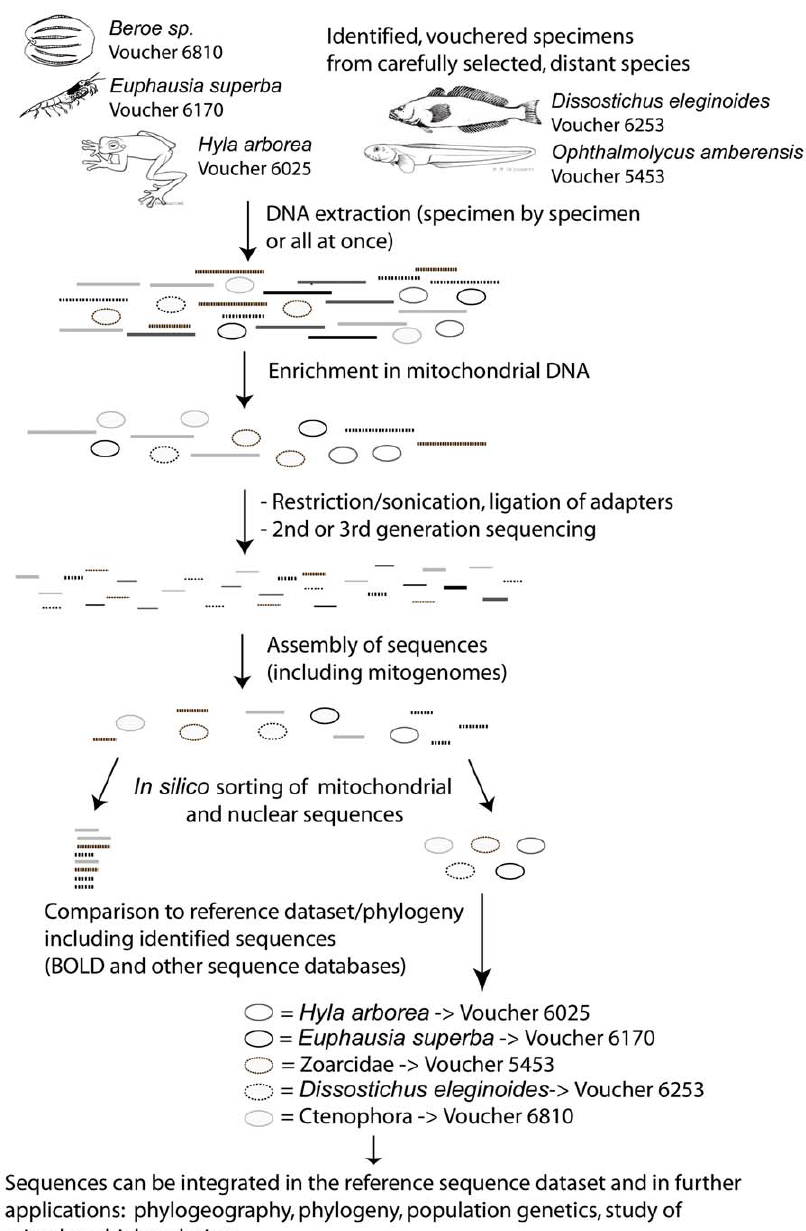
Figure 2. Summary of the approach for identified and individualized metazoan samples. Samples are selected so the mitogenomes can be separated at a later